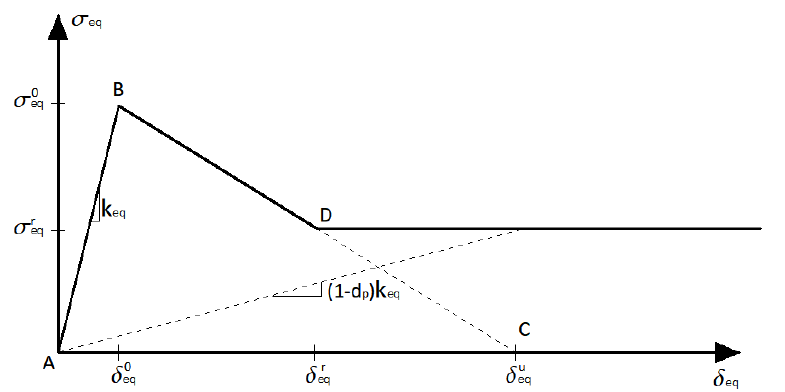
Figure 2. Constitutive relation with residual stress for the equivalent stress and equivalent displace- ment.